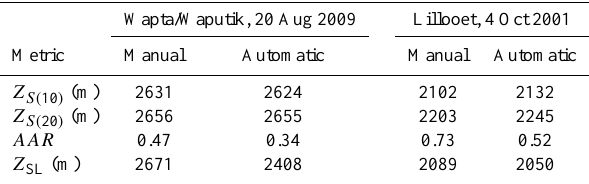
Table 5. Comparison of snow line metrics derived from manual de- lineation of snow and ice classes (Landsat scene) and automated classification from MOD02QKM cluster